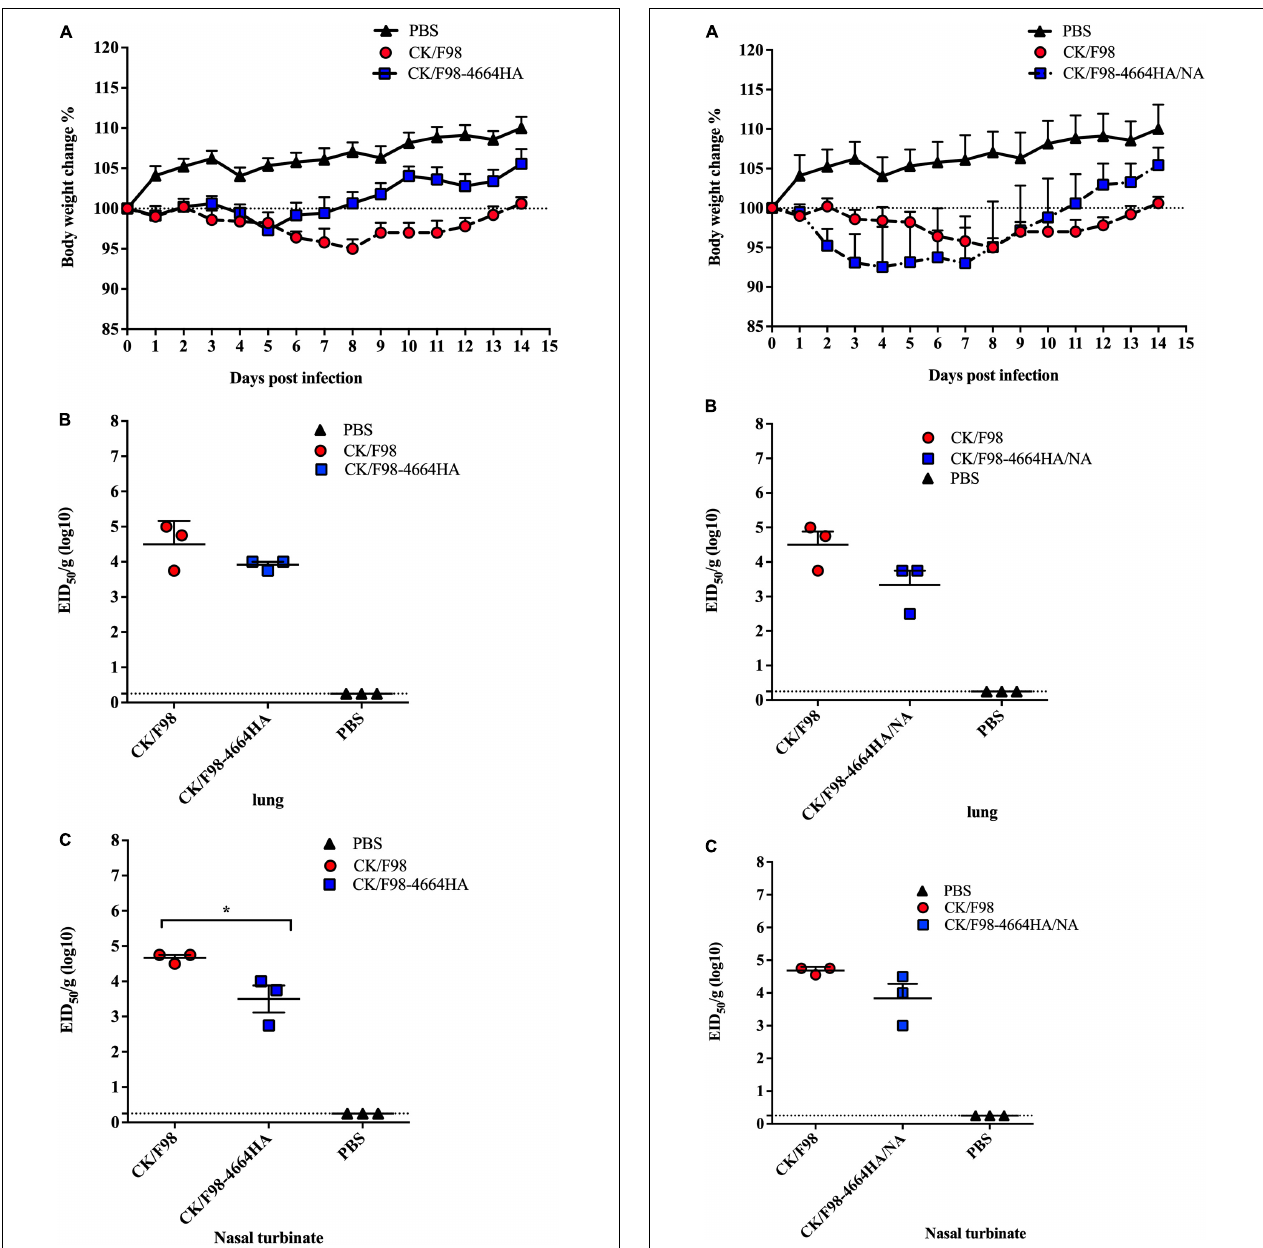
FIGURE 2 | H7N9-derived HA was not able to enhance the pathogenicity and replication of H9N2 virus in mouse. Mice were intranasally inoculated with a single dose of 10 6 EID 50 of either the parental H9N2 CK/F98 virus or the CK/F98-4664HA hybrid virus with HA gene being replaced by its counterpart from H7N9 SH/4664 virus. (A) Weight loss during a 14-day observation period. (B) Virus titers in animal lungs, as determined by EID50 using MDCK cells. (C) Virus titers in animal nasal turbinates, as determined by EID50 using MDCK cells. n = 3 for each group. Data are expressed as mean ± SEM. * P < 0.05 by one-way ANOVA.